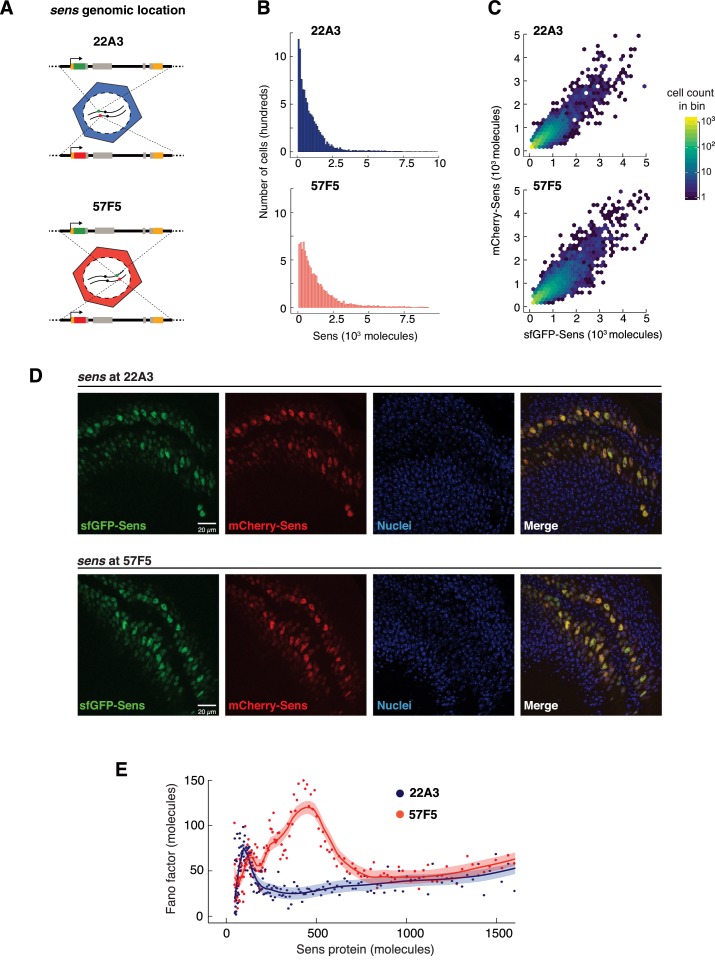
Genome location of the sens gene dramatically affects Sens noise.(A) The sens transgenes were inserted into one of two locations on chromosome II - 22A3 or 57F5. (B) Histograms depicting the frequency distribution of Sens protein number per cell. 10,000 cells were randomly sampled from 22A3 and 57F5 datasets each for comparison (see also Figure 5—figure supplement 1). (C) Scatter plot with hexagonal binning of single-cell sfGFP-Sens and mCherry-Sens protein numbers from sens genes inserted at 22A3 or 57F5. Randomly chosen subsets of 6,000 cells were plotted for each genotype for ease of comparison. Colors represent cell counts in respective hexagonal bins. (D) Confocal micrographic images of sfGFP- and mCherry-Sens fluorescence in wing discs expressing the sens gene inserted at 22A3 or 57F5. Nuclei are counterstained with DAPI (blue). Scale bars are 20 μm. Image brightness is enhanced (identically across 22A3 and 57F5) for ease of visualization. (E) The Fano factor profiles from cells expressing sens at 57F5 or 22A3. Cells with more than 800 molecules have identical Fano values at both genomic positions. The Fano peaks at lower Sens levels are very different between the genomic locations. Shaded regions are 95% confidence intervals.